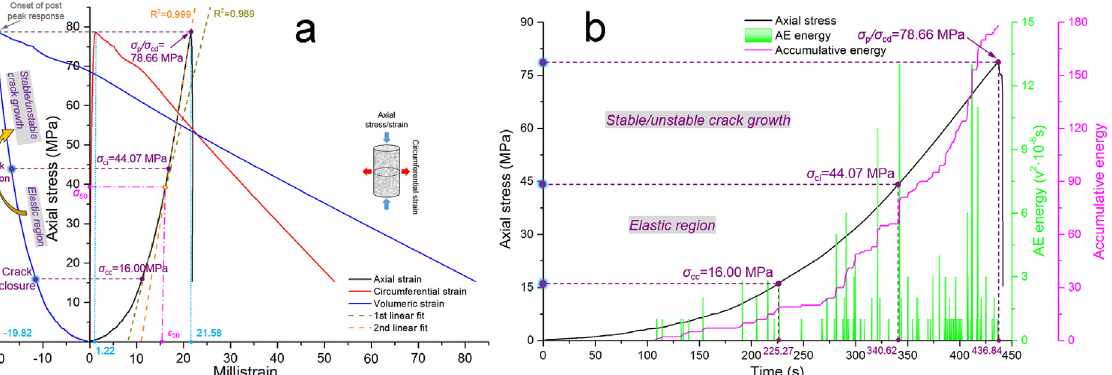
Fig 4. Test results of intact sandstone No. 1. (a) Relationship between the axial/circumferential/volumetric strain and axial stress under uniaxial compression. (b) Relationship between the time and axial stress/AE energy/accumulative energy under uniaxial